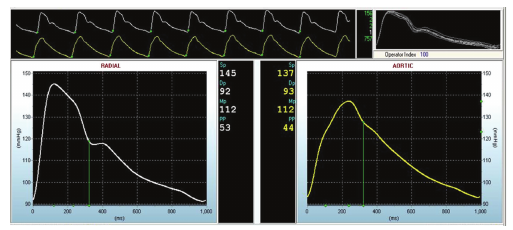
Figure 3: Radial artery applanation tonometry recording. The upper long panel shows the radial pressure waveform above the derived central pressure waveform. The upper right panel shows the overlaid radial waveforms, including the operator index, and the middle panel shows the quality control indices. The bottom left panel demonstrates a magnified radial arterial waveform. Systolic and diastolic pressures are 145/92 mmHg. The bottom right panel provides a magnified derived central pressure waveform. Central pressure is 137/93